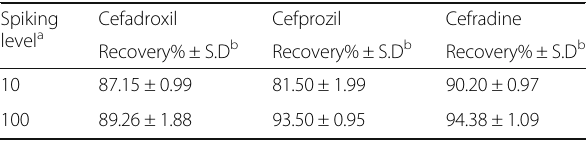
Table 1 Mean recovery of the selected antibiotics using